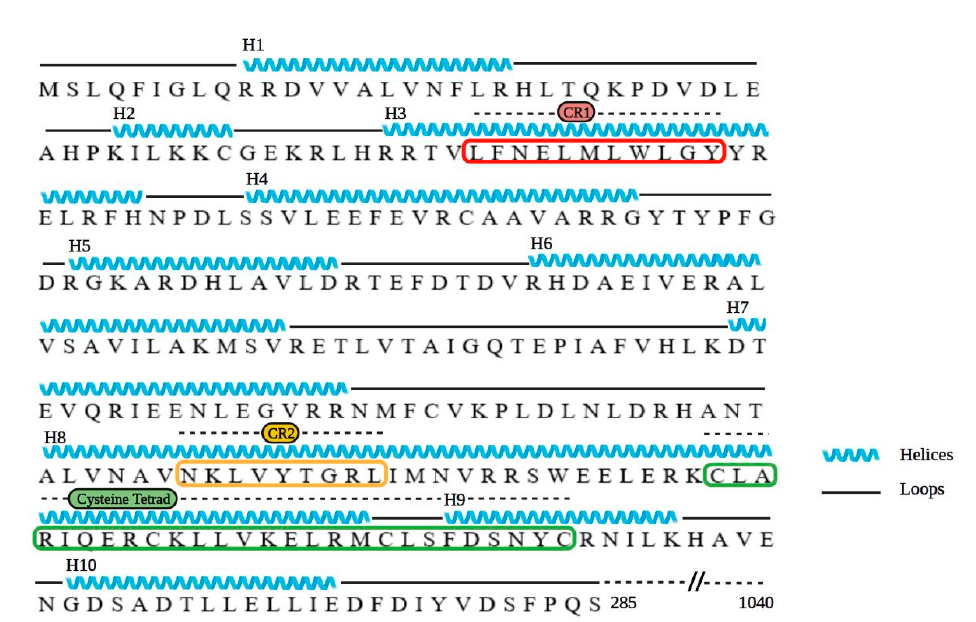
Figure 2. Amino acid sequence and structure-derived secondary structure of pp150nt. Black lines represent loops, blue lines represent helices, CR1 is boxed in red, CR2 boxed in yellow and cysteine tetrad boxed in green. Illustrated in BioRender.com (access date: 10 November 2021) using RSCB PDB ID: 5VKU and UNIPROT ID: Q6SW99 [22] .